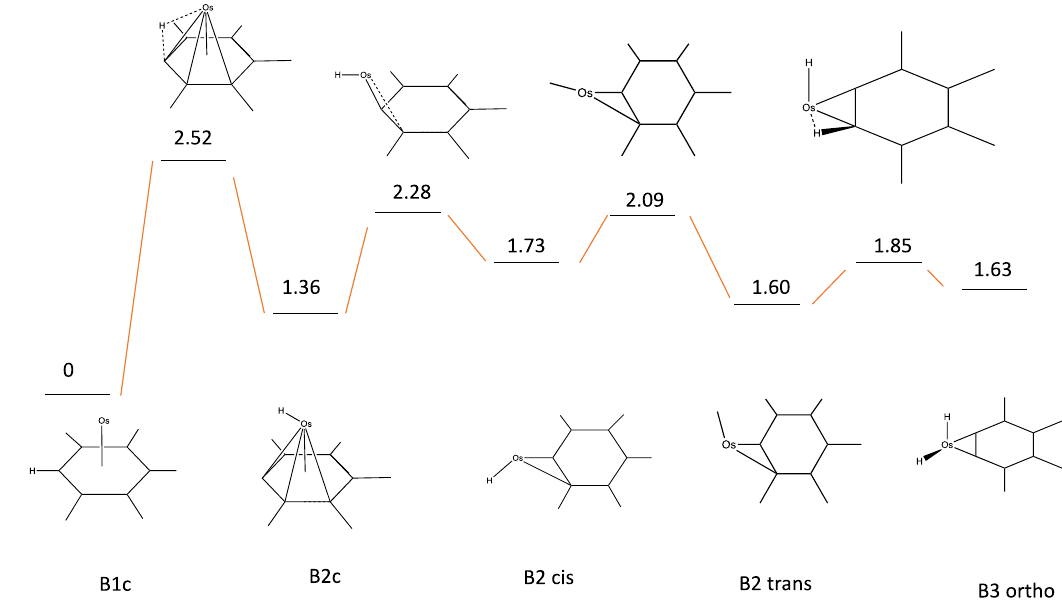
Figure 12. Landmarks in the B path for the production of H 2 .